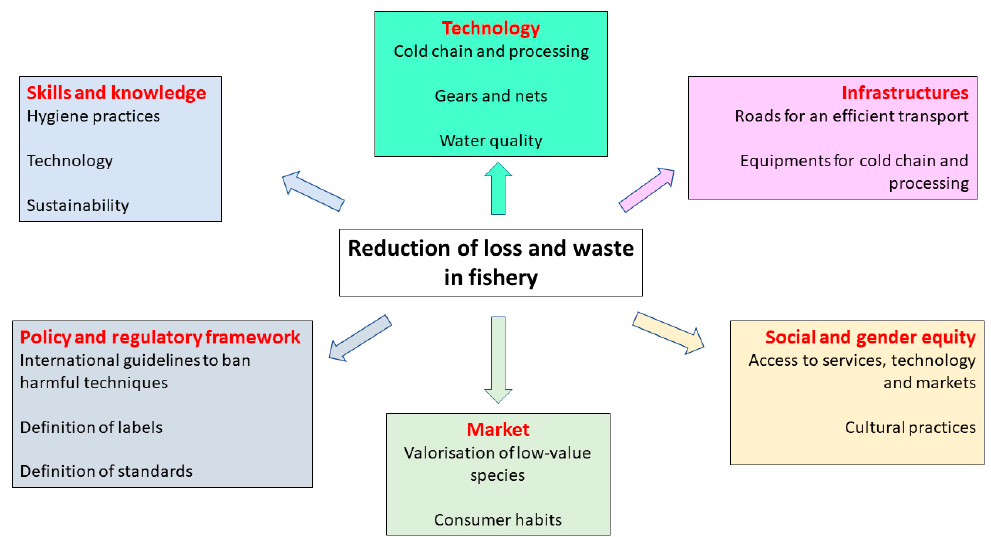
Figure 3. The challenges of food loss and unwanted catches require solutions in at least six different lines. This figure reports on the needs to be addressed for each line.